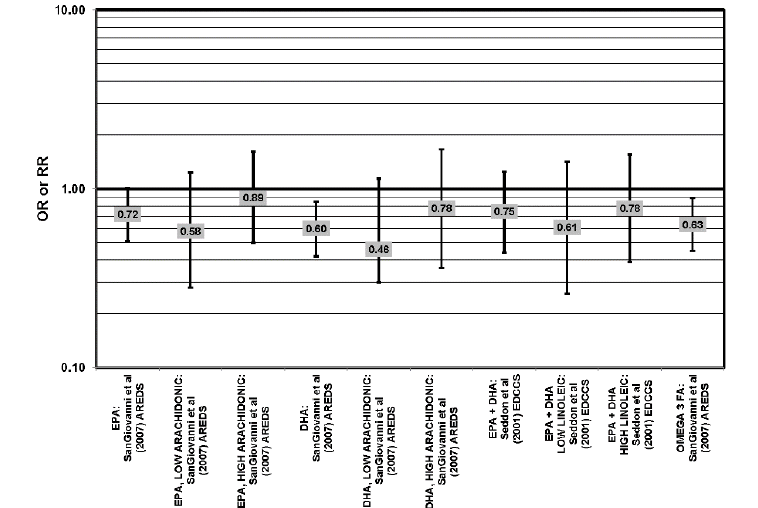
Figure 5. Neovascular AMD odds or risk ratio, high vs. low intake of omega-3 fatty acids: retrospective and cross-sectional